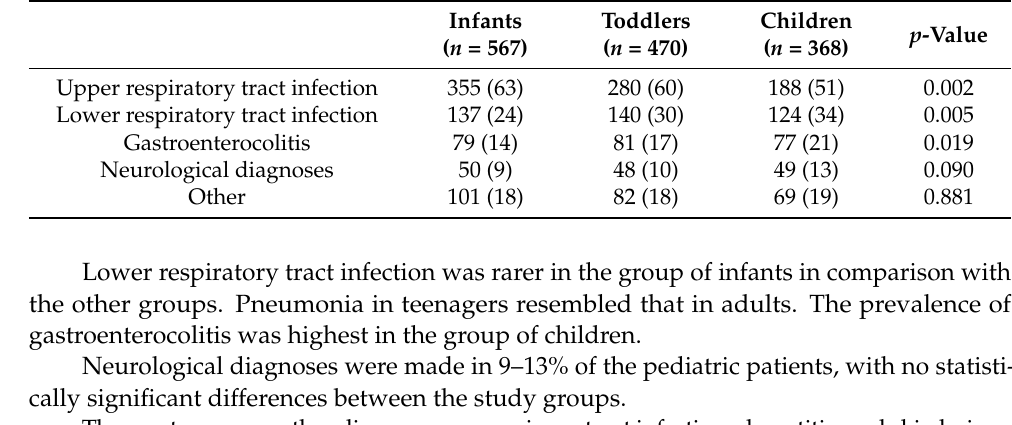
Table 5. Final diagnoses in hospitalized pediatric patients with COVID-19 according to